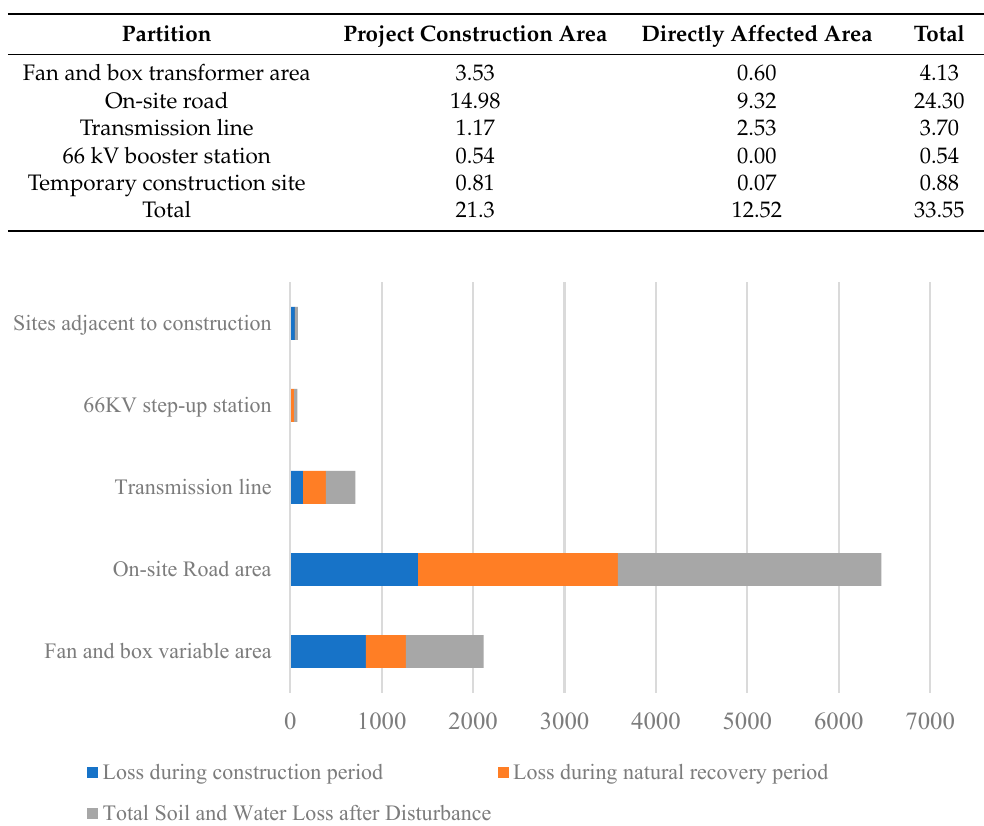
Figure 15. Distribution of water and soil loss in each region.